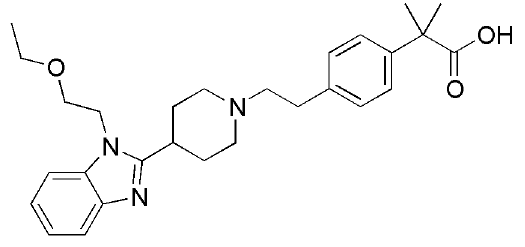
Figure 1. Chemical structure of Bilastine.